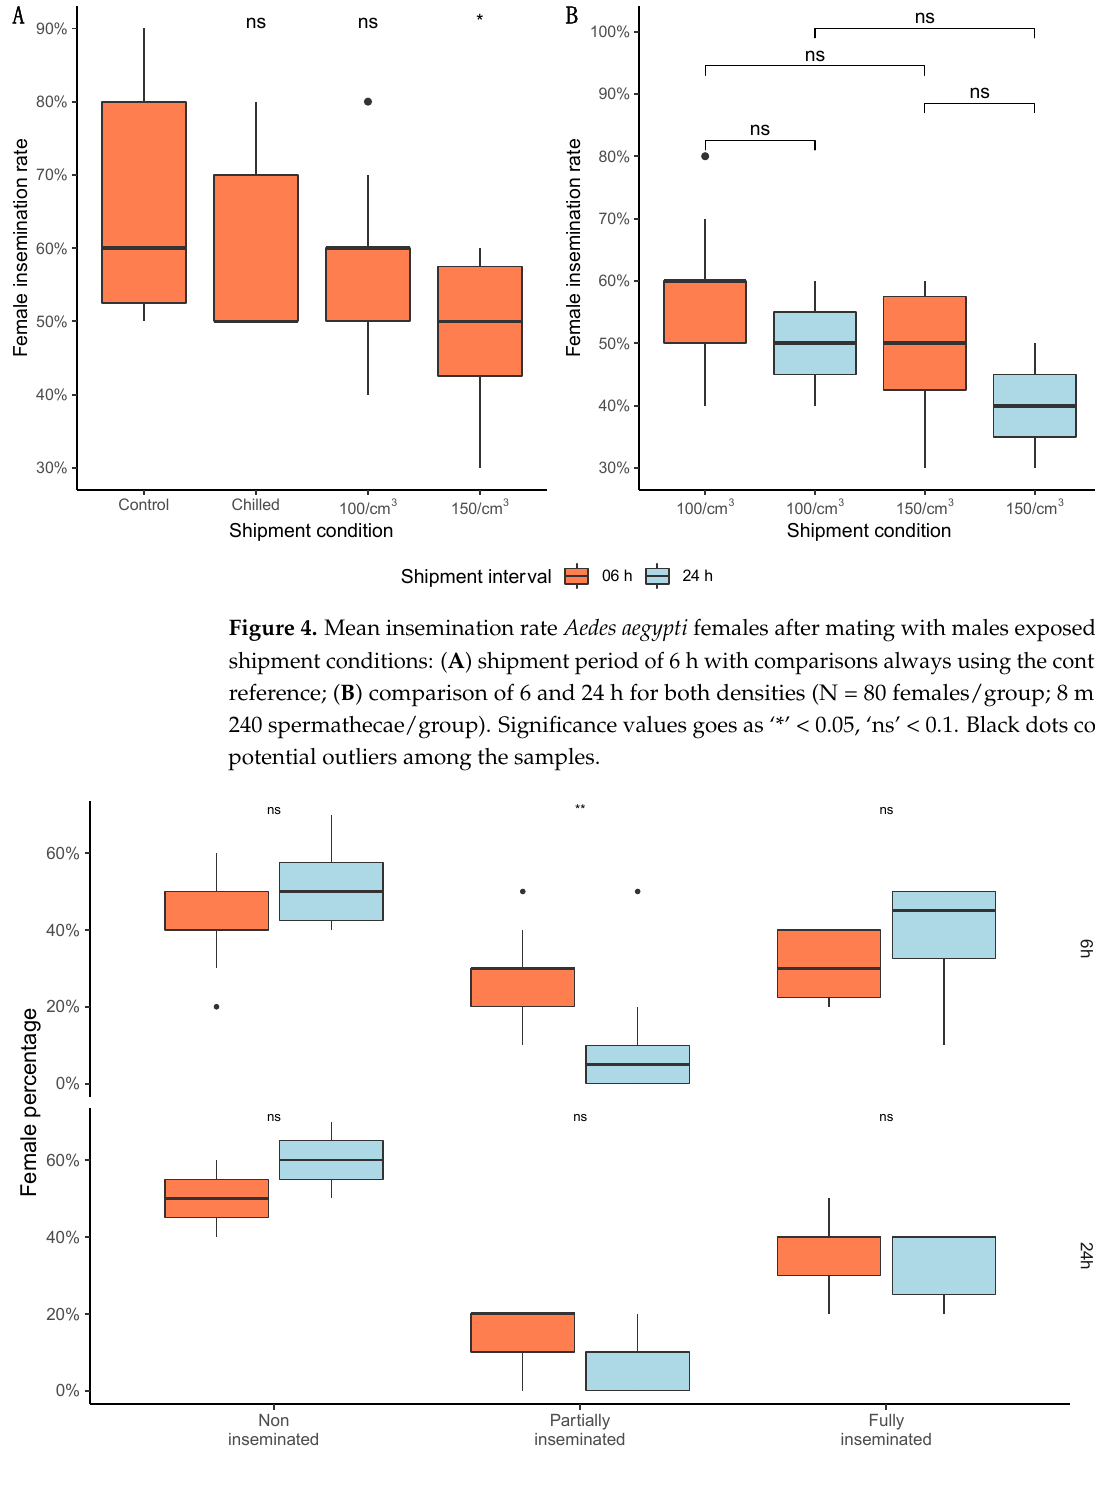
Figure 5. Insemination level of Aedes aegypti females after mating with exposed males at two different compaction densities and two shipment periods (N = 80 females/group; 8 males/group) (Wilcoxon–Mann–Whitney, p < 0.05). Significance values goes as ‘**’ < 0.01, ‘ns’ < 0.1. Black dots correspond to potential outliers among the samples.